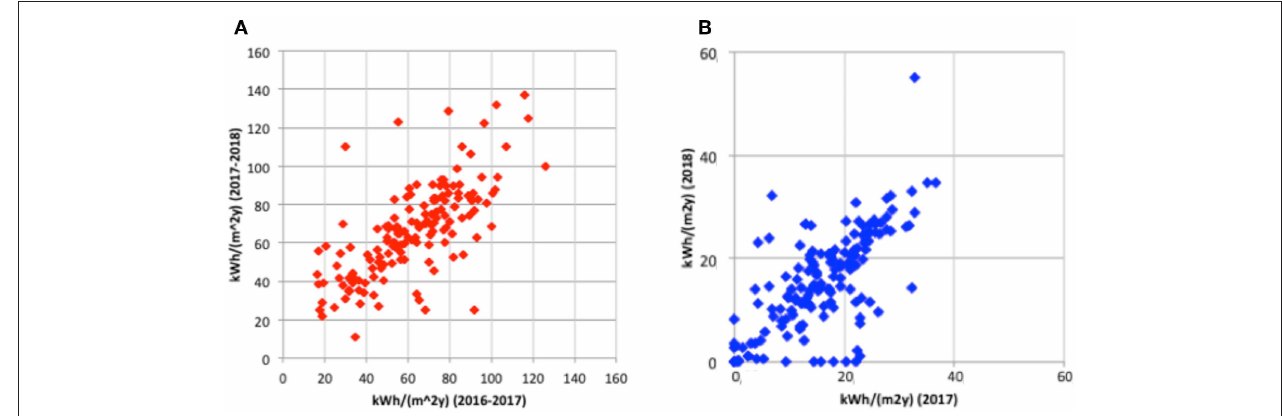
FIGURE 9 | Comparison of the normalized thermal energy consumption for heating between the two analyzed winter seasons (A) and comparison of the thermal energy consumption for cooling between the two analyzed summer seasons (B)